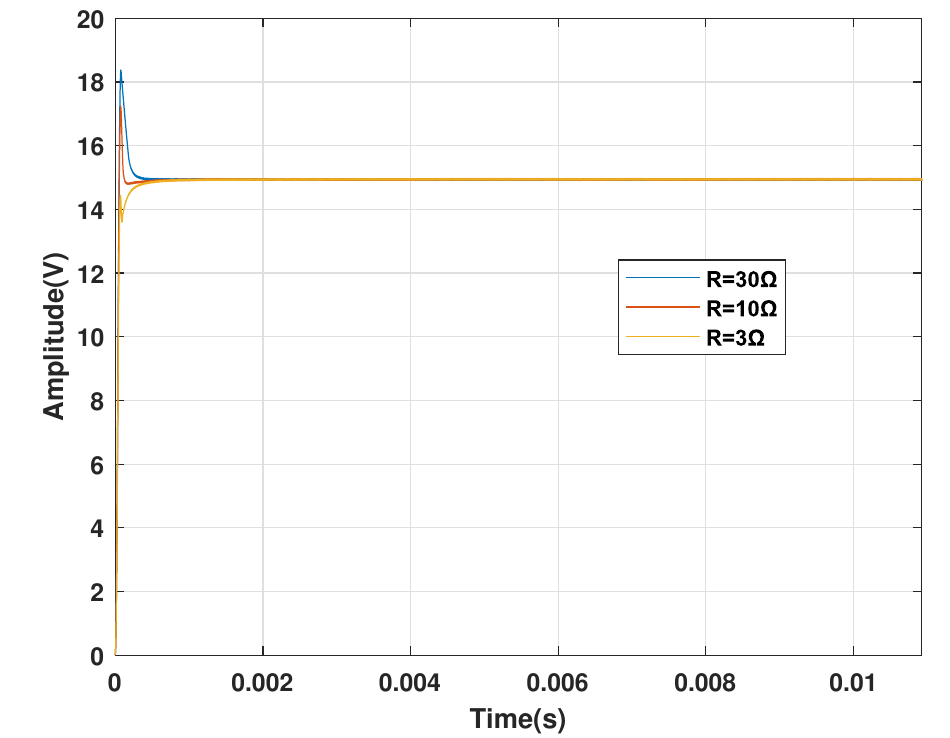
Figure 13. CI optimized system response to load variations.